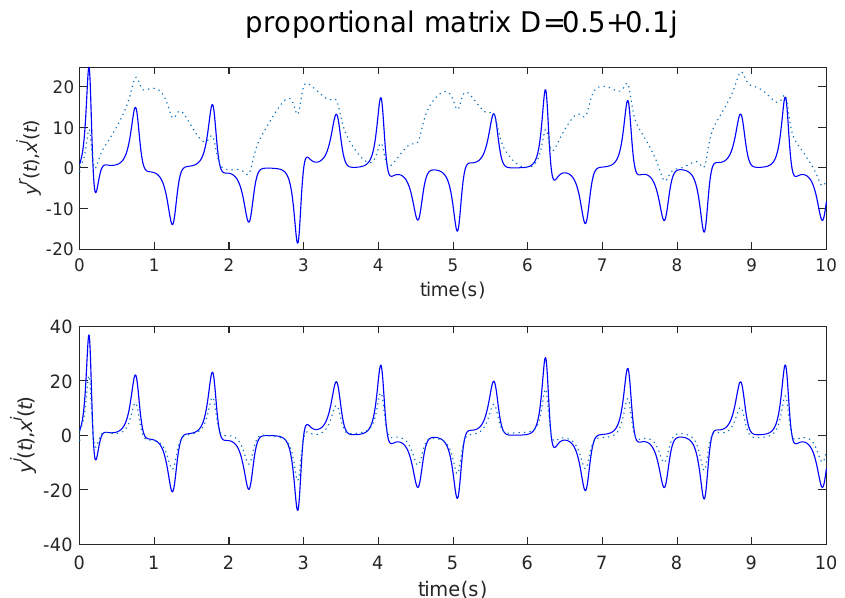
Figure 9. The diagram of state variables x 1 and y 1 with noise A = 50. traditional chaotic masking